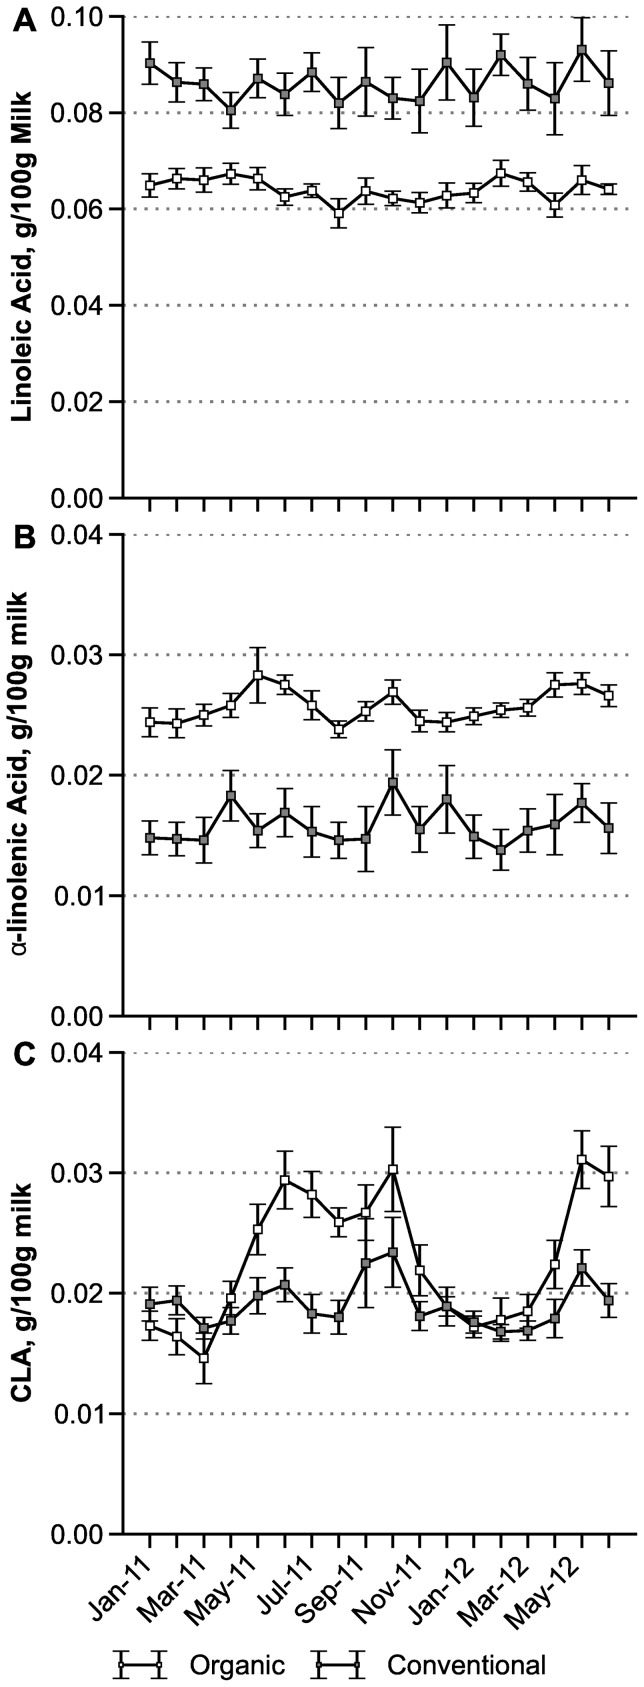
Seasonal variation in polyunsaturated fatty acid content of retail whole milk, g/100 g, 18 monthly averages ± SE.A: Linoleic acid (LA, ω-6). B: α-linolenic acid (ALA, ω-3). C: Conjugated linoleic acid (CLA). The number of monthly samples in all panels is 10 to 13 for organic and 7 to 10 for conventional milk, except 5 conventional in October 2011. For LA and ALA, all differences between organic and conventional contents are statistically significant by Mann-Whitney test (P<0.02).